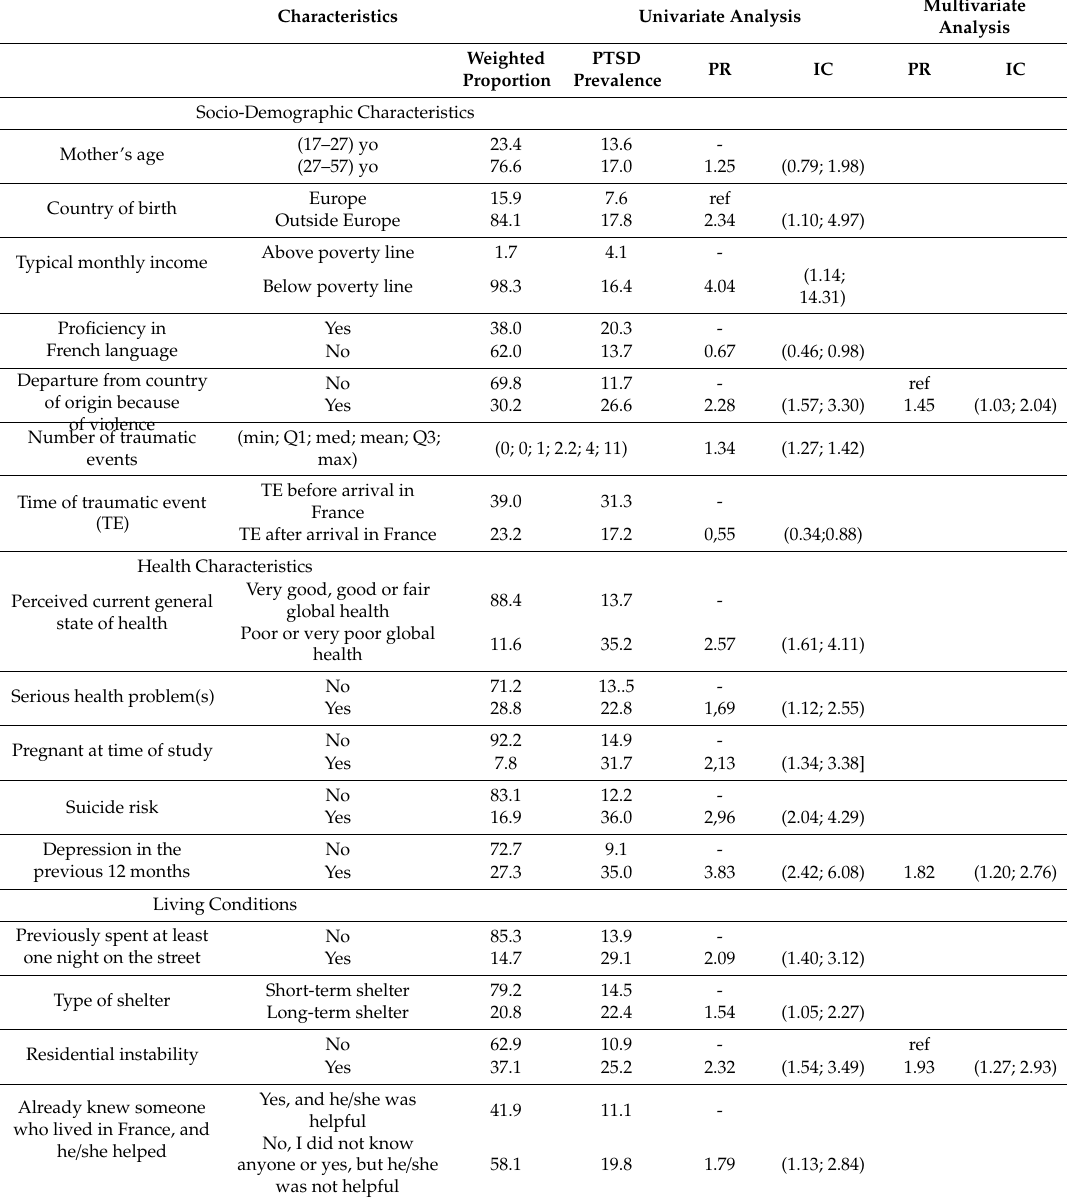
Table 4. Characteristics associated with PTSD in the last 12 months in homeless migrant mothers in the Paris region (ENFAMS survey 2013, n = 691, univariate and multivariate Poisson regression analyses). Multivariate Characteristics Univariate Analysis Analysis Weighted PTSD PR IC PR Proportion Prevalence